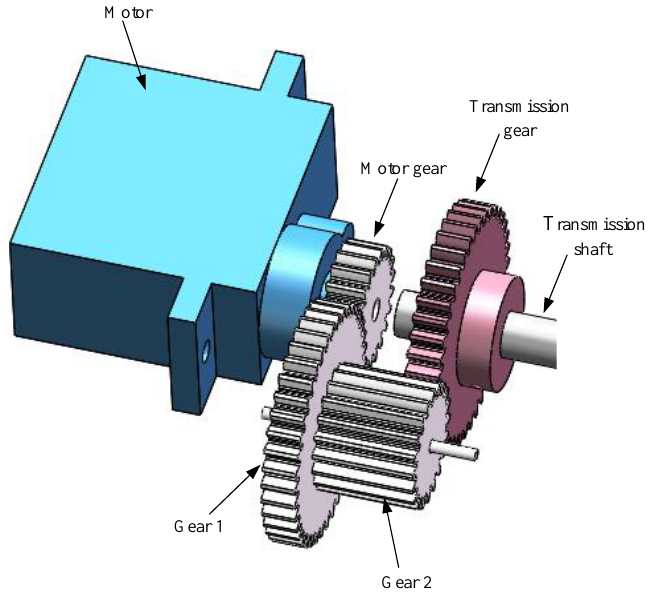
Figure 12. The transmission system.